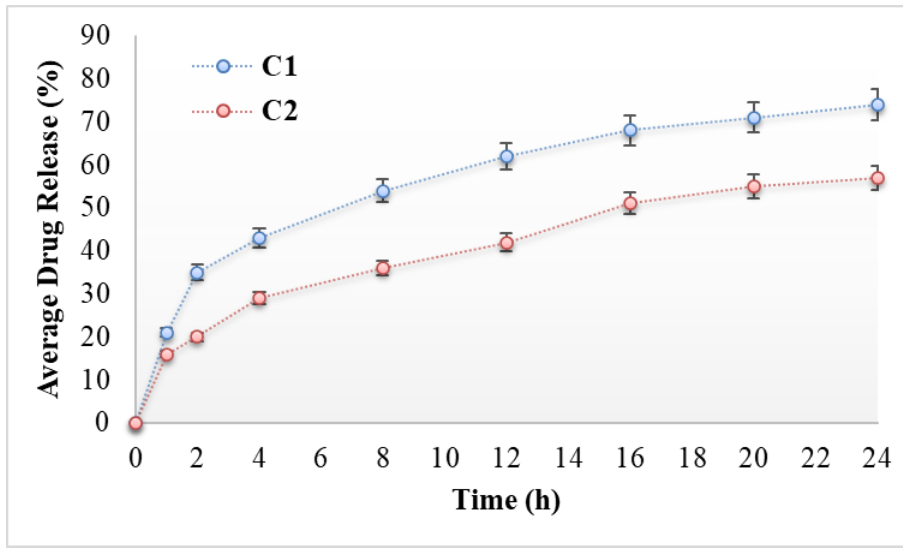
Figure 4. In vitro drug release profiles of C1 and C2.